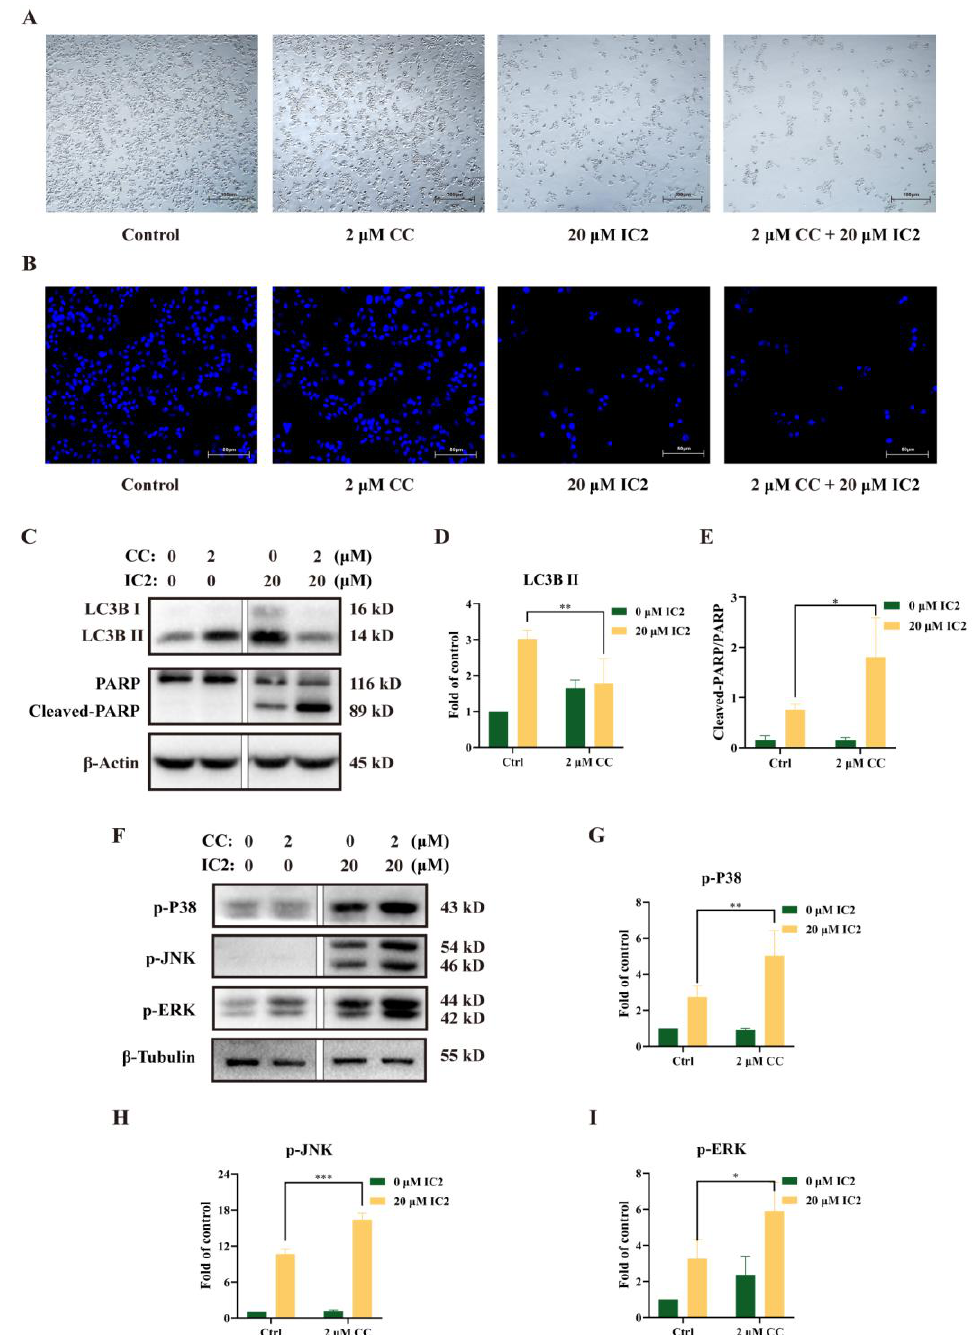
Figure 4. Inhibition of autophagy by AMPK inhibitor increases IC2-induced apoptosis and activation of MAPK signaling in MCF-7 cells. The cells were treated with IC2 for 24 h in the presence or absence of CC. ( A ) Representative images of MCF-7 cells were captured by brightfield microscopy at 50 × magnification. ( B ) Representative images of DAPI staining were at 200 × magnification in MCF-7 cells. The expression of ( C ) LC3B, PARP, ( F ) p-P38 (Thr180/Tyr182), p-JNK (Thr183/Tyr185) and p-ERK (Thr202/Tyr204) was determined in MCF-7 cells by Western blot. Quantification of the protein expression levels of ( D ) LC3B II, ( E ) Cleaved-PARP/PARP, ( G ) p-P38 (Thr180/Tyr182), ( H ) p-JNK (Thr183/Tyr185) and ( I ) p-ERK (Thr202/Tyr204) in MCF-7 cells. All blots are representative of at least three repeats. * p < 0.05, ** p < 0.01 and *** p < 0.001 compared with the control